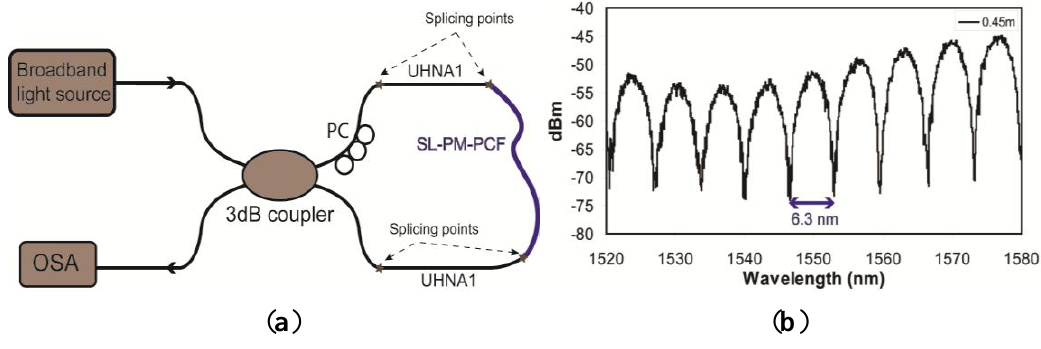
Figure 4. ( a ) Configuration of Sagnac loop for birefringence measurement; ( b ) output optical spectrum of the Sagnac